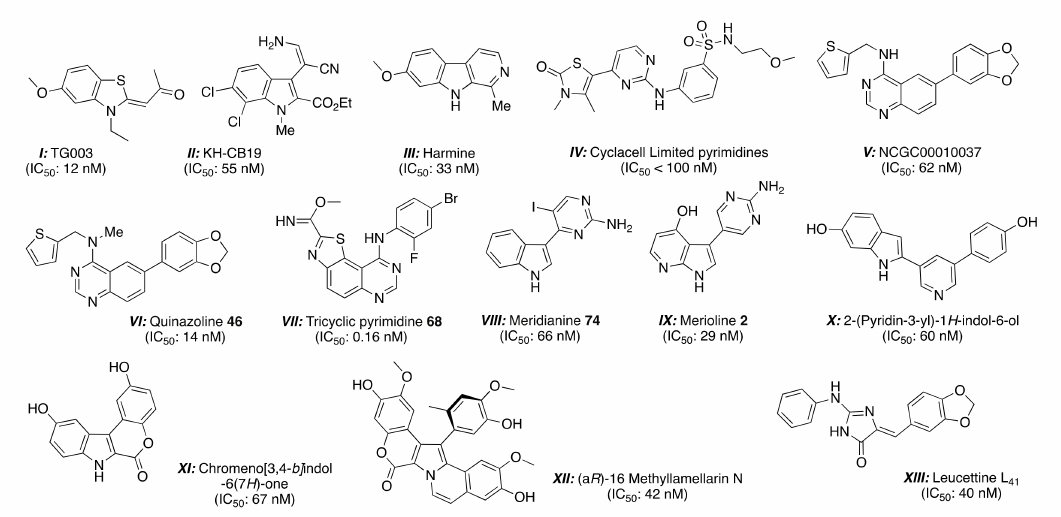
Figure 1. Reported small molecules as DYRK1A kinase inhibitors with their IC 50 values in